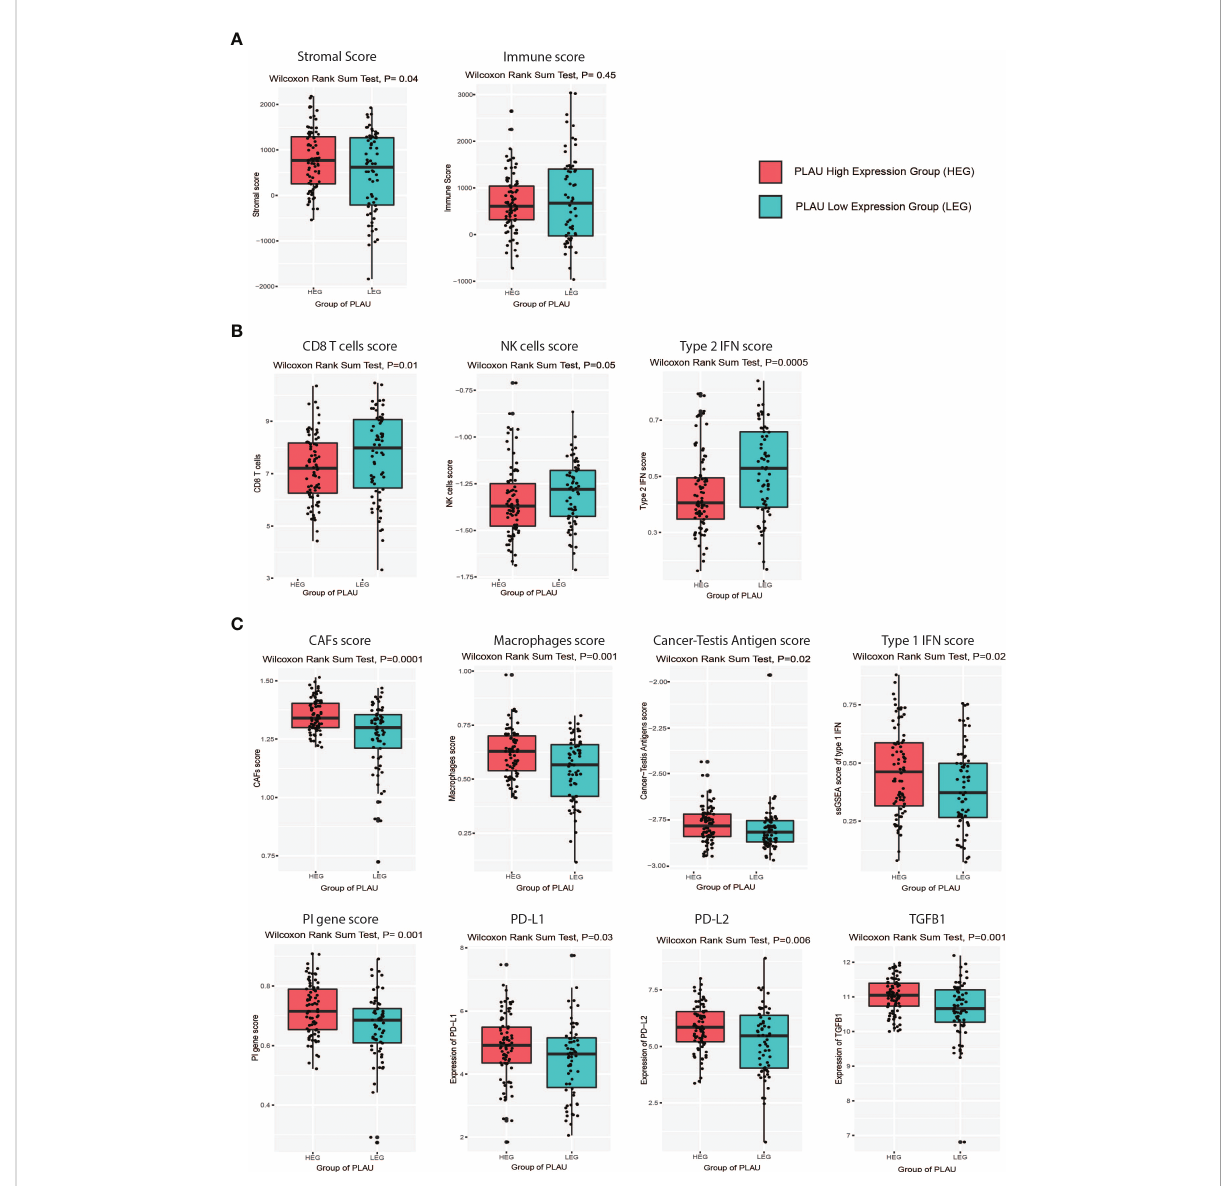
FIGURE 9 Association of PLAU upregulation with an immunosuppressive landscape in the TCGA PDAC cohort. Markers of an immunosuppressive landscape in PDAC were positively correlated with the high PLAU expressing group (HEG) compared to the low PLAU expression group (LEG), as evidenced by (A) a high stromal score (Wilcoxon rank-sum test, P=0.04) and a low immune score (Wilcoxon rank-sum test, P=0.45), (B) low scores for immune stimulatory signatures CD8+ T cells (Wilcoxon rank-sum test, P=0.01), NK cells (Wilcoxon rank-sum test, P=0.05), and type 2 IFN (Wilcoxon rank-sum test, P=0.0005), (C) high scores for immune inhibitory signatures including CAFs (Wilcoxon rank-sum test, P=0.0001), macrophages (Wilcoxon rank-sum test, P=0.001), cancer-testis antigens (Wilcoxon rank-sum test, P=0.02), Type 1 IFN (Wilcoxon rank-sum test, P=0.02), PI genes (Wilcoxon rank-sum test, P=0.001), PD-L1(Wilcoxon rank-sum test, P=0.03), PDL-2(Wilcoxon rank-sum test, P=0.006), and TGFB1 (Wilcoxon rank-sum test,